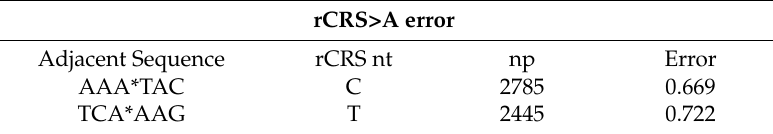
Table 4. Nucleotide positions and adjacent sequence for locations with the highest frequency error for each nucleotide type (A, C, G, and T). The adjacent sequence preceding and following the error site (noted as *) as given by the L-strand of the rCRS (NC_012920). The surrounding sequence is limited